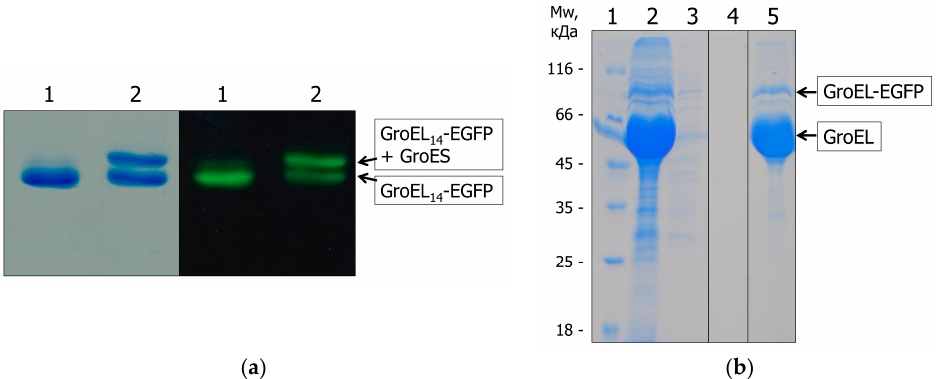
Figure 5. Binding of purified GroEL 14 -EGFP to GroES ( a ); binding of GroEL 14 -EGFP from cell extract (coexpression, see Materials and Methods (Section 4)) to denatured lysozyme ( b ). ( a ) Nondenaturing PAGE in the presence of Mg-ADP without GroES (Lane 1) and after incubation with GroES at the 1:5 molar ratio (Lane 2), as detected by Coomassie staining (left panel) and EGFP fluorescence (right panel) in the same electrophoretic gel; ( b ) SDS-PAGE of the results of affinity chromatography based on denatured lysozyme of the cell extract (coexpression): Lane 1, molecular-weight markers; Lane 2, loading; Lane 3, breakthrough; Lane 4, washing; Lane 5, elution by 6 M urea. Three lanes are three parts of the same gel.